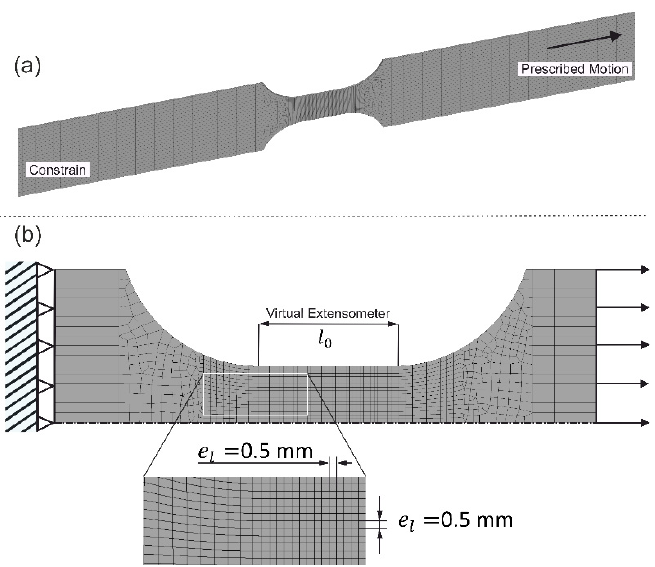
Figure 5. Displacement of the traverse during the tests for actual strain rates of ( a ) 0.08/s and ( b ) 60/s.